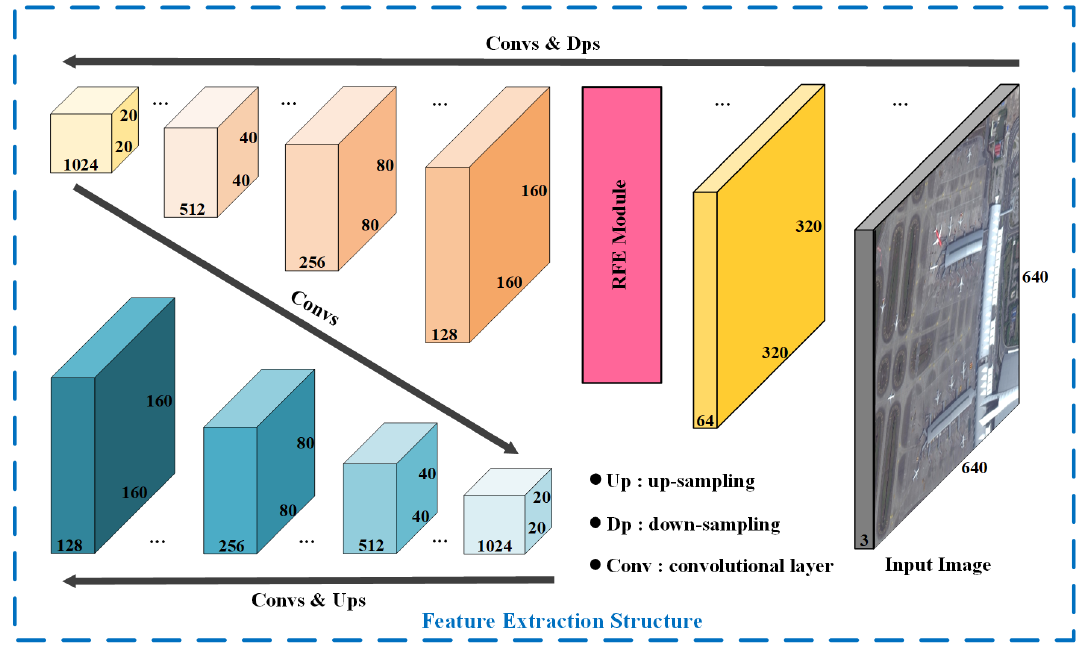
Figure 4. Feature extraction structure. The feature extraction structure of novel effectively optimized one-stage network (NEOON) constructs top-down and bottom-up inference through a series of dwon-sampling operations and corresponding up-sampling